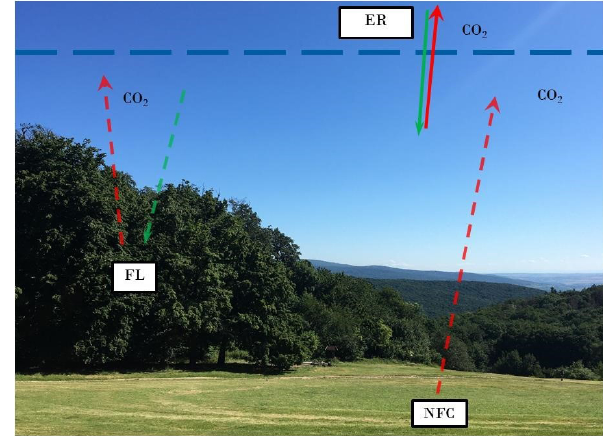
Figure 1. The three main carbon fluxes considered in this paper, consisting of emissions from net forest conversion (NFC), emis- sions and removals on forest land (FL), and their aggregate, repre- senting total net emissions/removals from forests (ER). Photo copy- right: Francesco N.